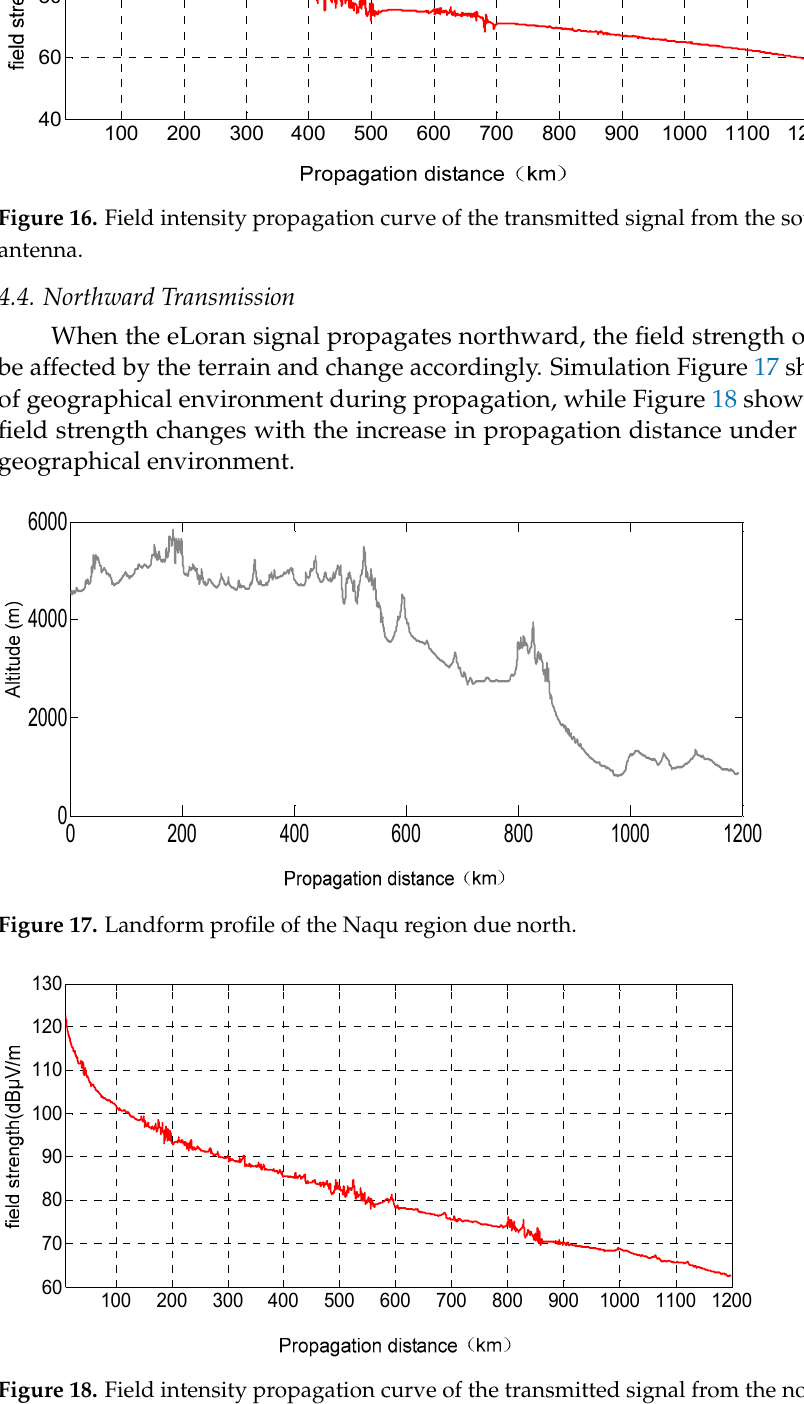
Figure 15. Landform profile of the Naqu region due south.